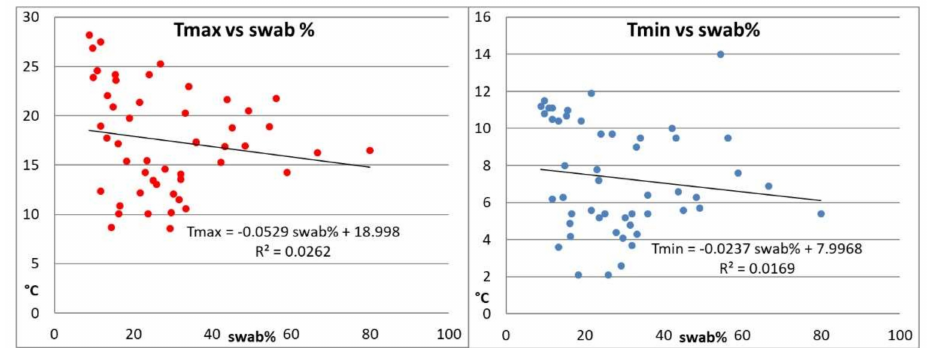
Figure 4. Relationships between percentage of first positive swabs and temperatures (maximum and minimum, to the left and to the right respectively) for the time span 1 March–20 April. R2 is the determination coe ffi cient of the interpolating